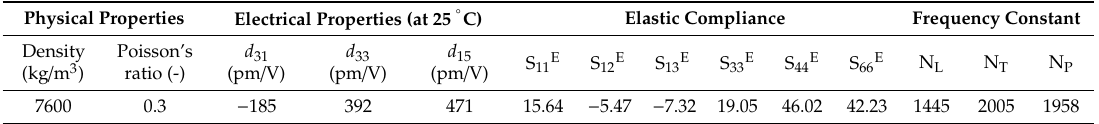
Table 2. Electrical and mechanical properties of Pb(Zr,Ti)O 3 (PZT).